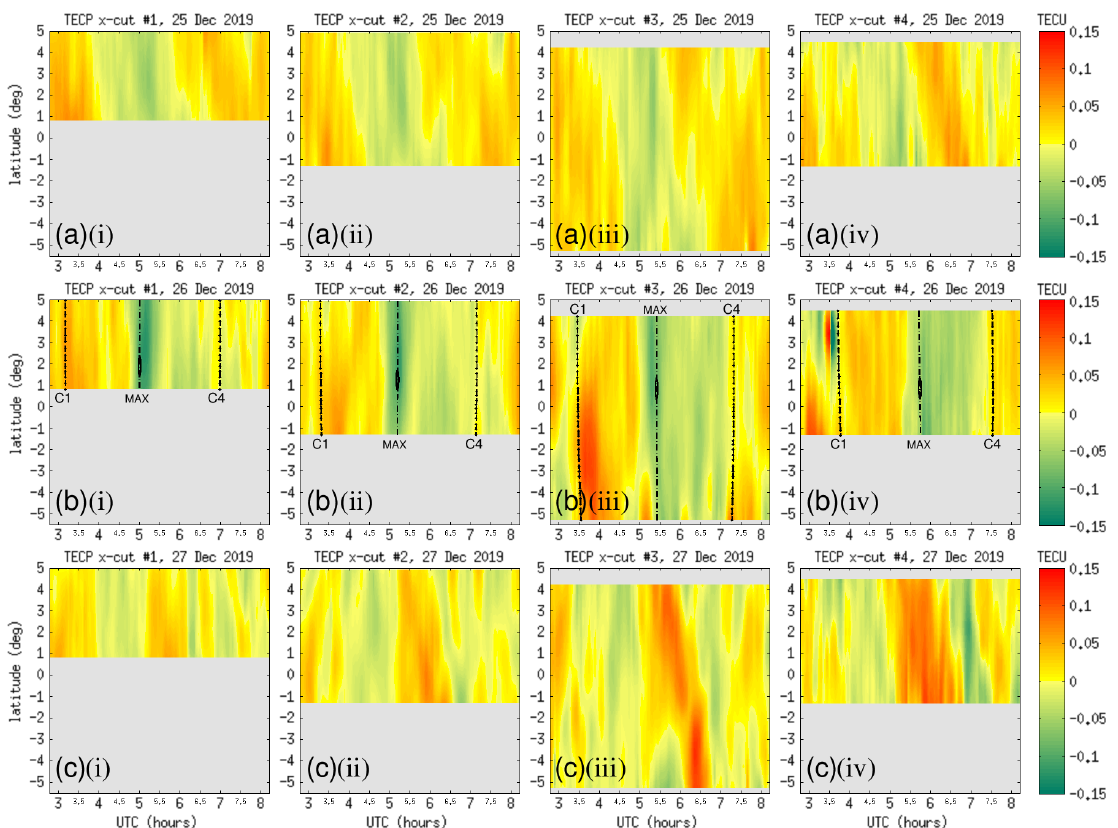
Figure 15. Color-map plots of TECP values as a function of time and latitude along x-cut nos. 1 to 4 on (a) 25, (b) 26, and (c) 27 December 2019. Time intervals are magnified around the solar eclipse on 26 December 2019. The start and end times of the eclipse (C1 and C4) as well as the moment of maximum eclipse are indicated by dashed curves on the plots. The small bulge on the maximum eclipse line indicates the annularity